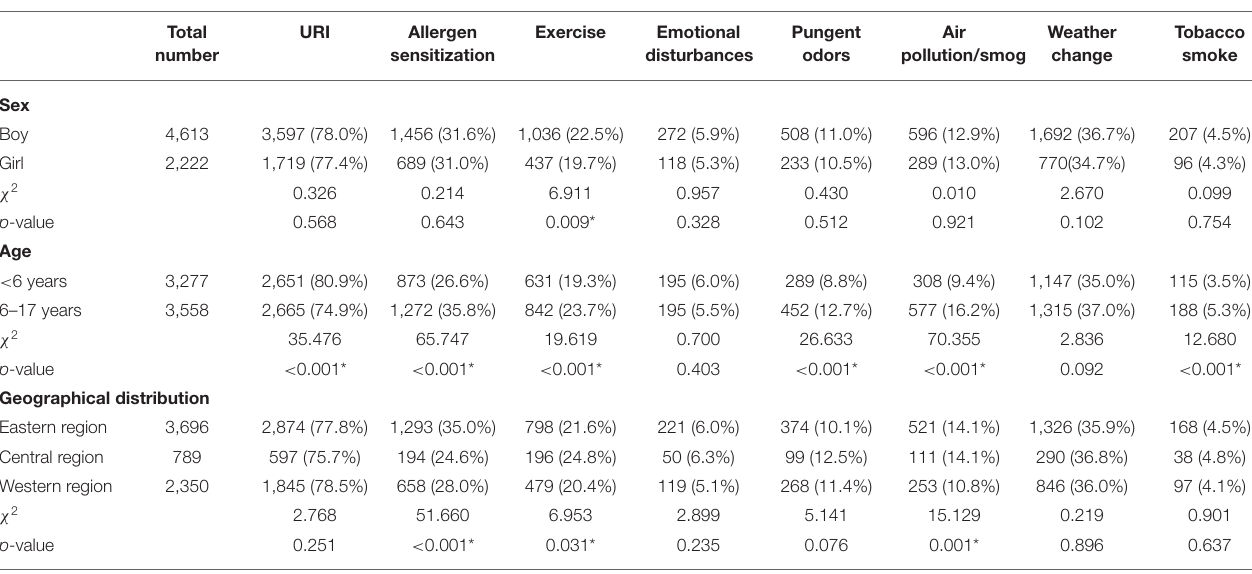
TABLE 3 | The distribution of asthma triggers among subgroups.